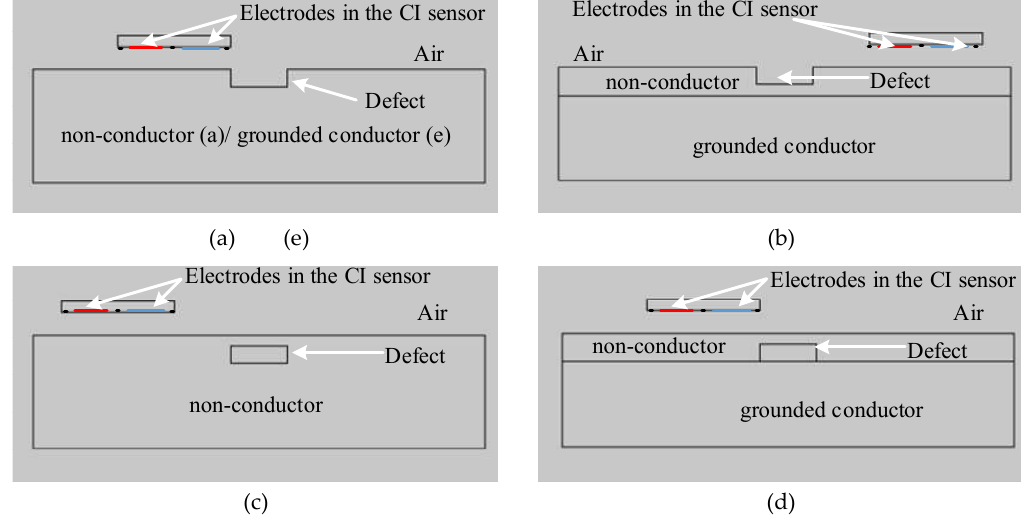
Figure 9. FE Model geometries for ( a ) Model 4, ( b ) Model 5, ( c ) Model 6, ( d ) Model 7 and ( e ) Model 8. The non-conducting material used in these 2D models is Perspex ( ℇ = 4) and the defects are filled with air ( ℇ = 1). Simulated line scans in these 2D models were with lift-offs varying from 0.5 mm to 4 mm, unless otherwise stated. To compare the ranges of capacitance variation due to the defect in different line scans, a characteristic value, namely Normalized Variation Ratio ( NVR ) is